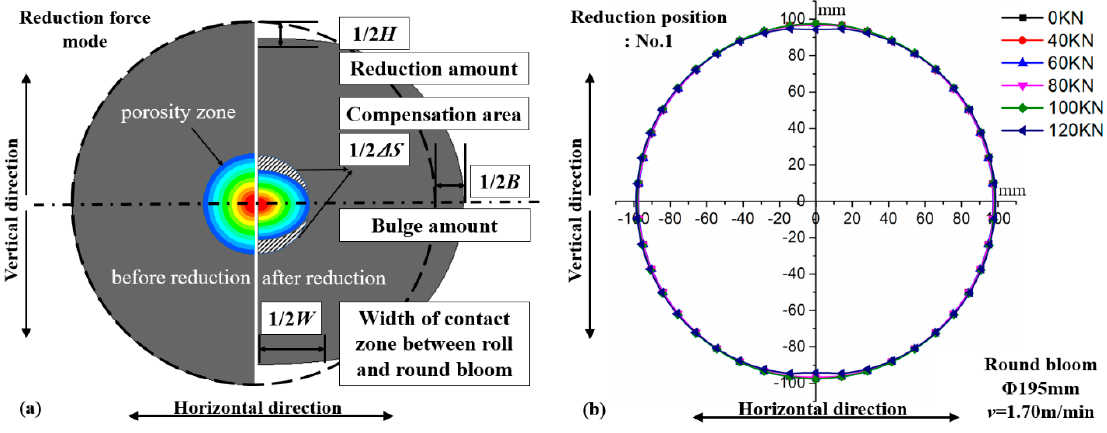
Figure 7. ( a ) Schematic of round bloom and porosity zone deformation, ( b ) Round bloom shape after SR.